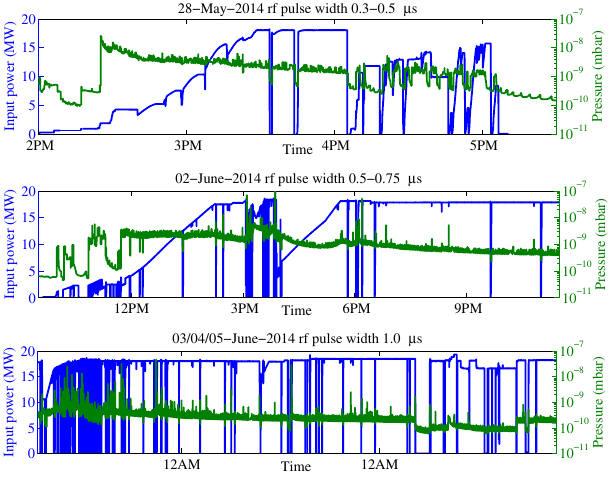
FIG. 15. Progress in rf conditioning the SwissFEL gun toward high power. The pressure gauge is mounted on the rf waveguide at the input of the rf gun.